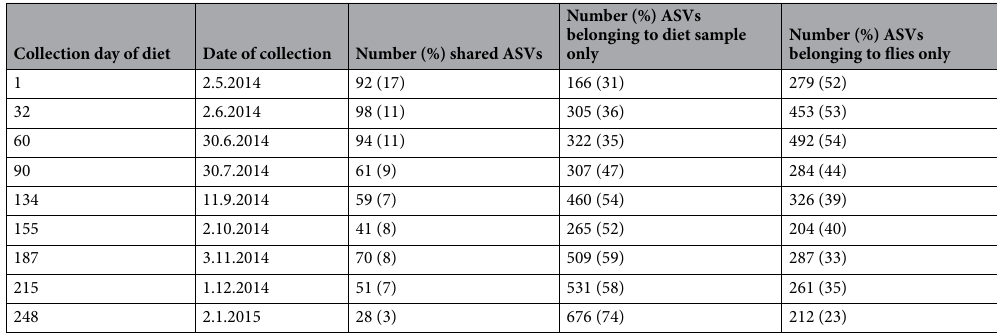
Number (%) ASVs belonging to diet sample only